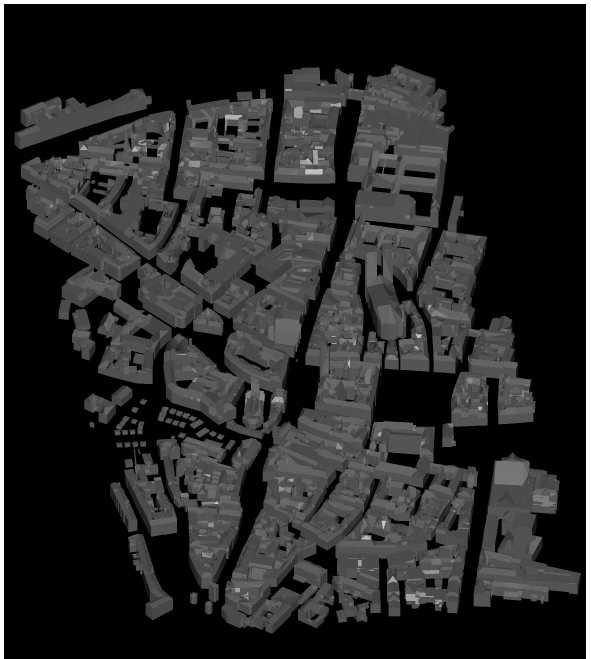
Figure 7. Rendered image of CityGML model, representing the line-of-sight of the virtual SAR